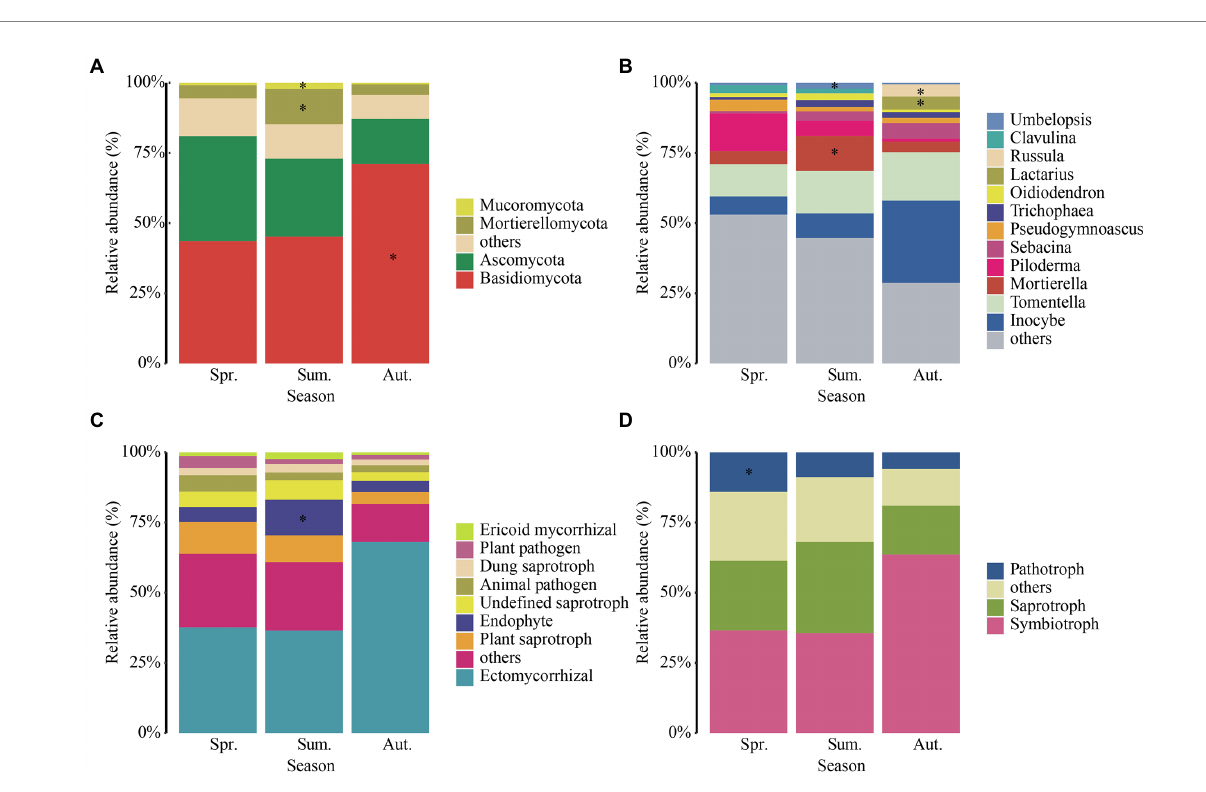
FIGURE 4 Relative abundances of dominant fungal phyla (A) , genera (B) , functional guilds (C) , and trophic modes (D) in each season. The phyla, genera, functional guilds, and trophic modes with less than 0.01of the average relative abundance are grouped into “others.” Asterisks indicate significant enrichment (FDR, p <